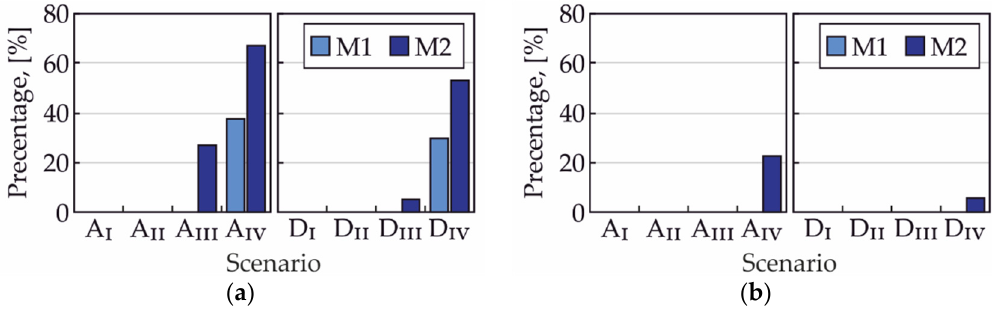
Figure 10. Annual share of critical moisture content exceedances for ACH = 3 h − 1 ( a ) and ACH = 9 h − 1 ( b ).